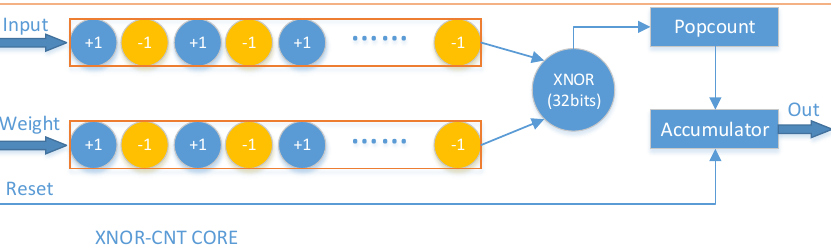
Figure 7. Hardware diagram of the XNOR-CNT